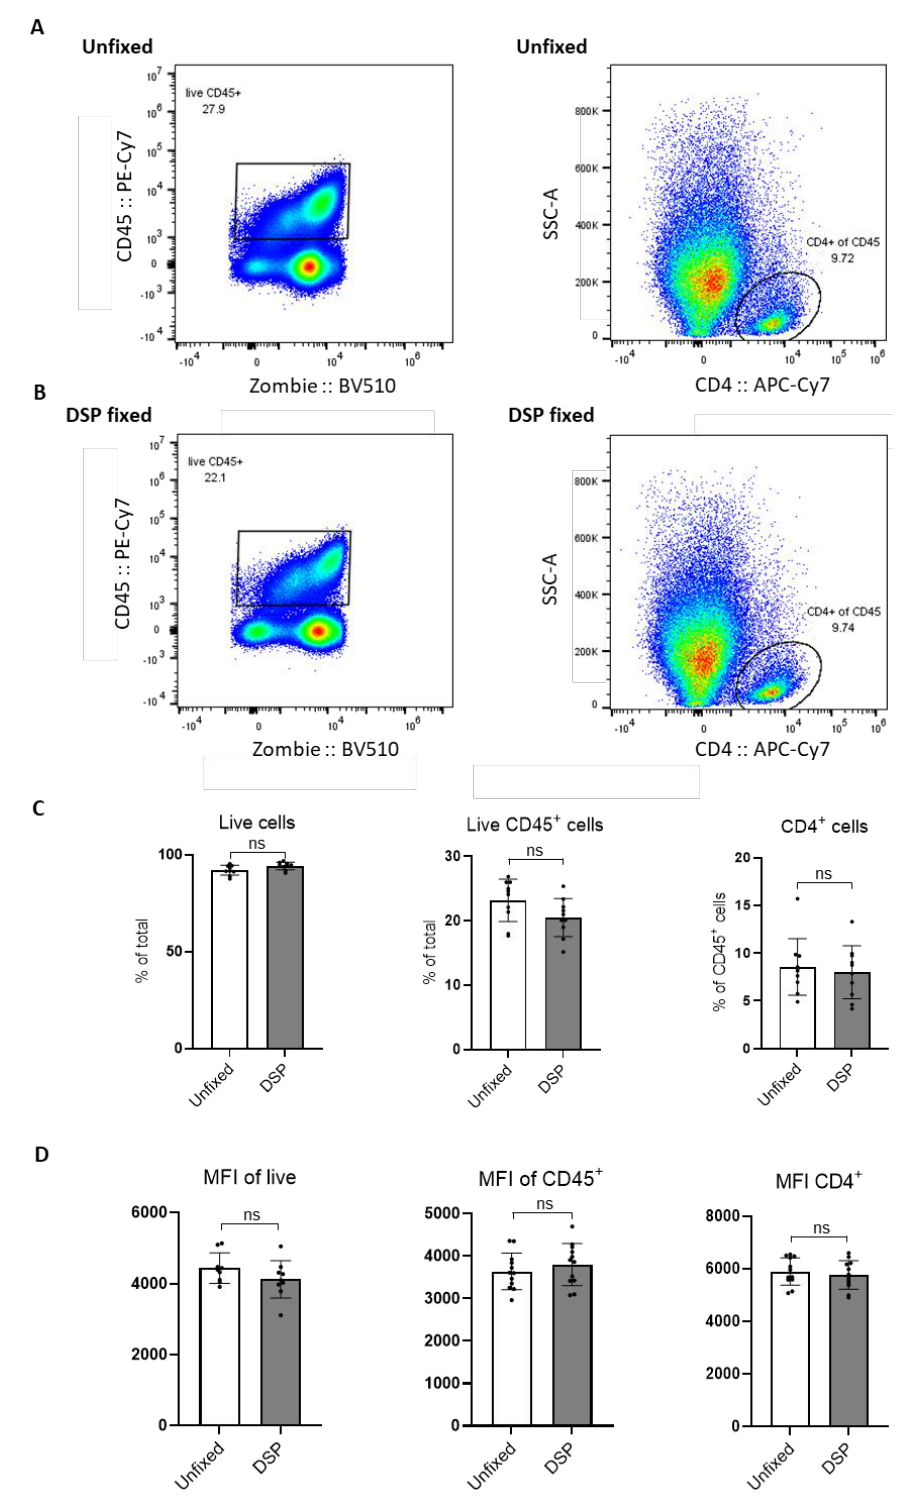
Figure 3. FACS analysis of unfixed and DSP-fixed cells from Pan02 tumors. Pan02 tumors were dissociated and cells processed for FACS. Representative gating strategy for live CD45 + and CD4 + cells in unfixed ( A ) and DSP-fixed cells. ( B ) Statistical analysis of percentage of live (Zombie − ), CD45 + , and CD4 + cells ( C ) and MFI of live, CD45 + , and CD4 + in unfixed and DSP-fixed cells ( D ); each dot denotes a separate processed tumor from a mouse; statistical analysis was performed using Student’s t -test; n = 10 (per group), p -value > 0.05